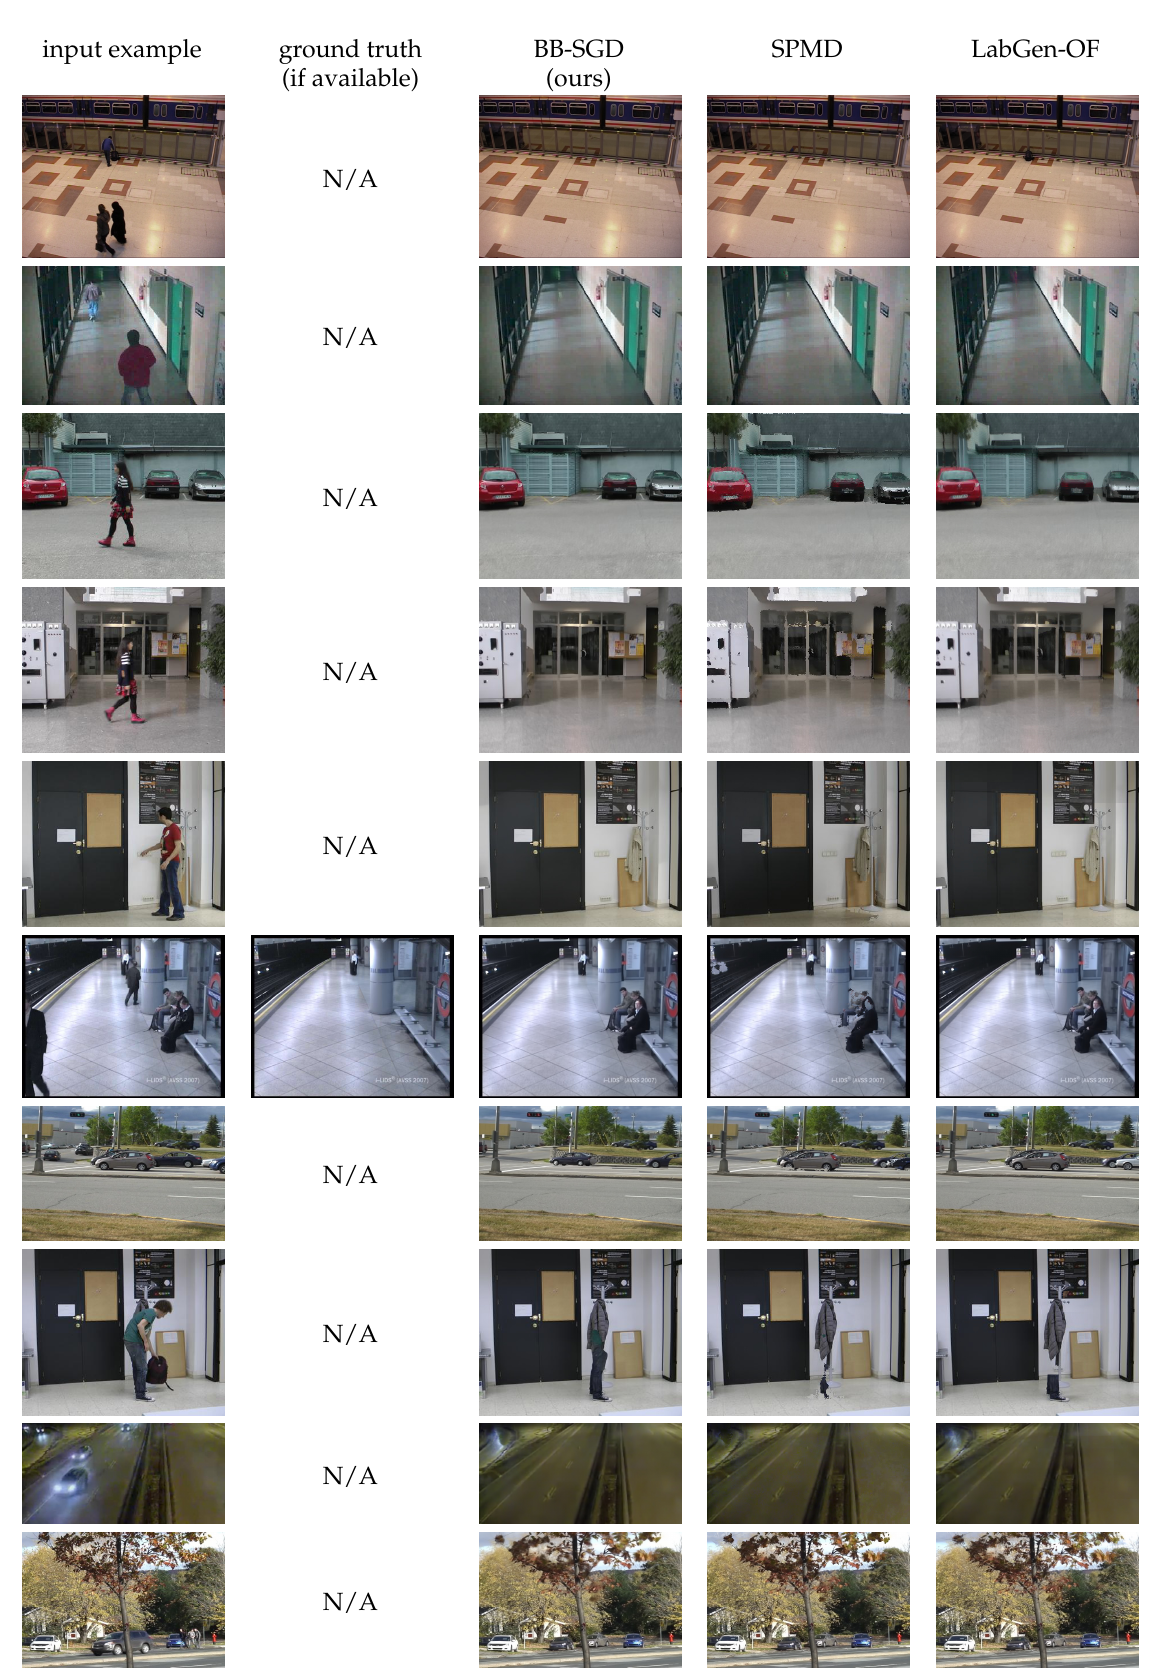
Figure 4. Examples of background reconstruction. The bottom five rows show examples of low quality